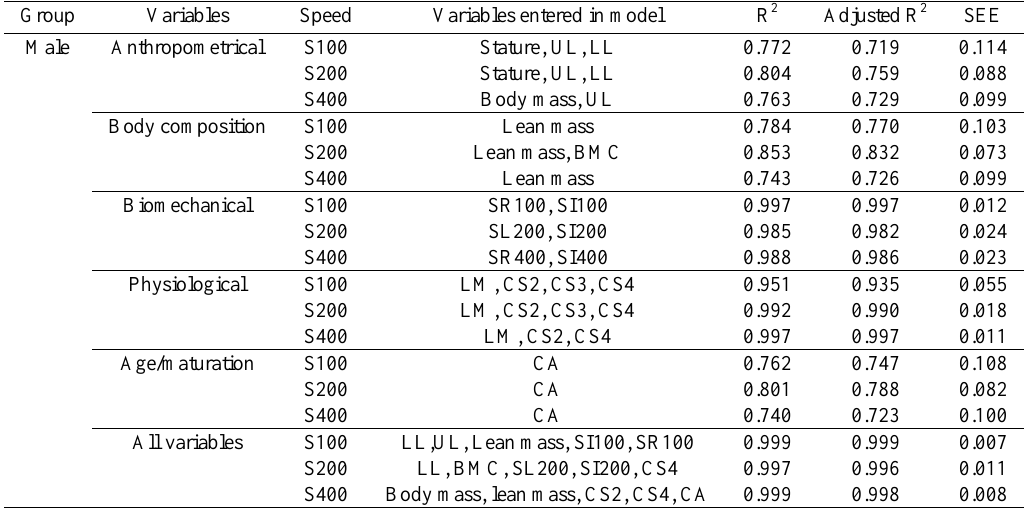
Table 2. Multiple linear regressions to determine the group of parameters (i.e., anthropometrical, body composition, biomechanical, physiological, age/ maturation, all variables) that best predict 100, 200 and 400 m performances in